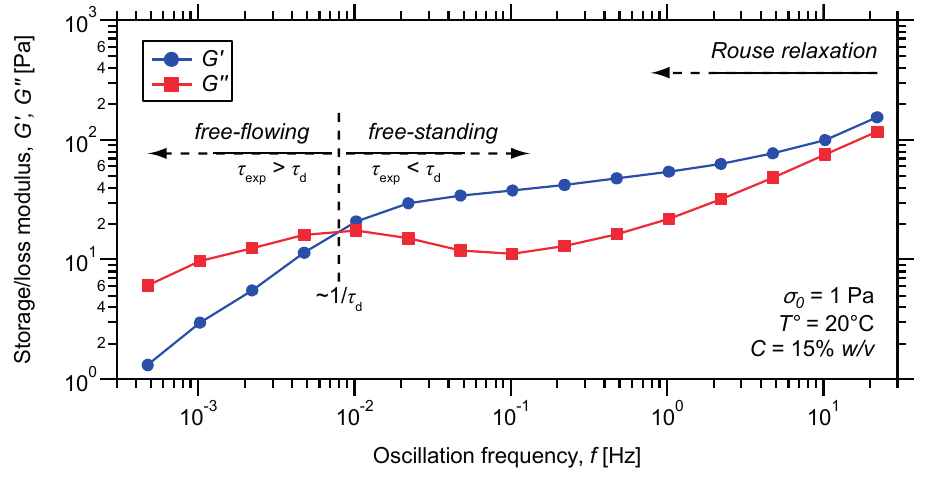
Figure 6. Oscillatory frequency sweep on a metallo-supramolecular hydrogel prepared from P(DMAMEA 200 - co -TpyMA 4.5 ) copolymer and 0.5 eq of Co (II)